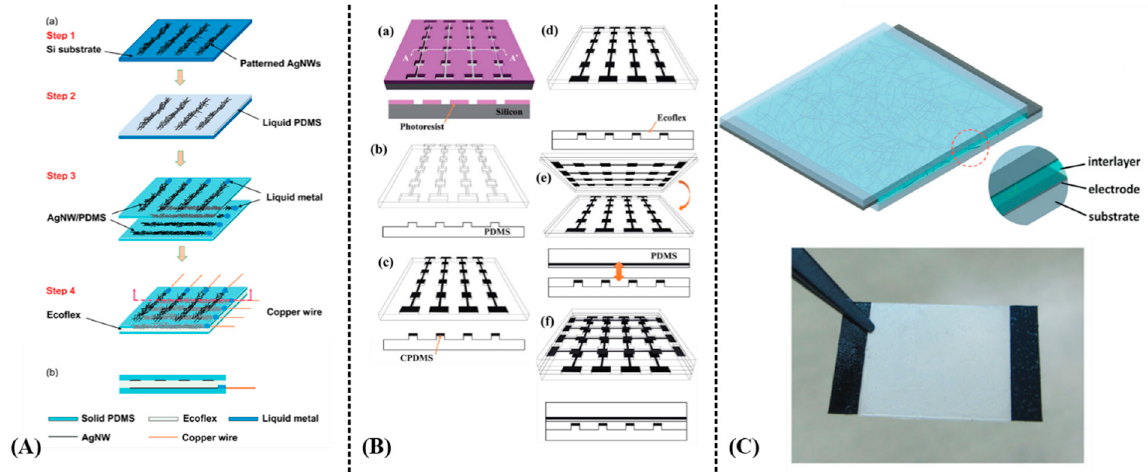
Figure 19. Various capacitive-based strain and pressure sensors: ( A ) a PDMS/AgNW/Ecoflex structure: device fabrication process ( a ); cross-sectional view of the device ( b ) (reproduced with permission from [69] copyright 2014, The Royal Society of Chemistry); ( B ) a PDMS/CNT/Ecoflex structure utilizing µ contact printing for fabrication. Micro-mold formation ( a ); PDMS stamp replication ( b ); CPDMS pattering via micro-contact printing ( c ); Ecoflex spin-coating ( d ); device assembly ( e ); thermal curing ( f ) (reproduced with permission from [70] copyright 2014, The Royal Society of Chemistry); ( C ) a different approach utilizing AgNWs and polyurethane on flexible substrate (reproduced with permission from [71] copyright 2015, The Royal Society of Chemistry). Note: the lowercase letters in the figure are kept from the original works, therefore the authors herein used capital letters for indication of each corresponding subfigure.